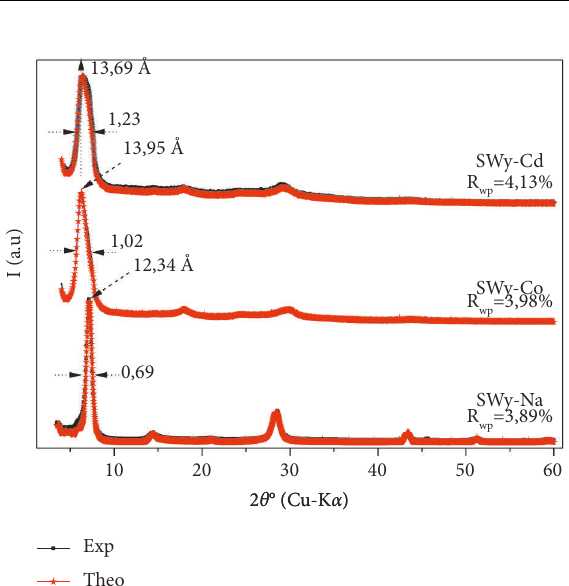
Figure 4: Best agreement obtained between theoretical (red scatter) and experimental (black line) profiles for all studied